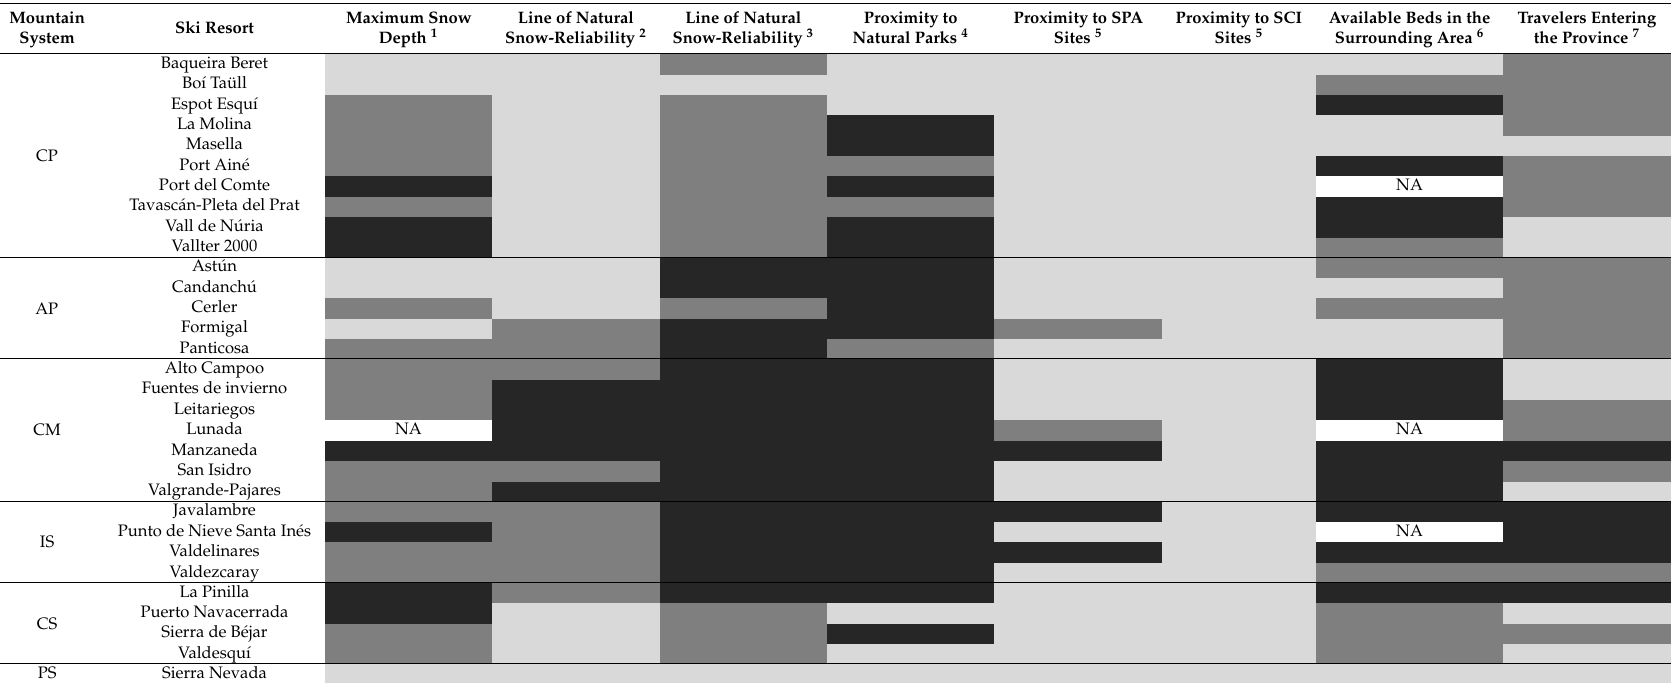
Table 4. Vulnerability analysis of alpine ski resorts to climate